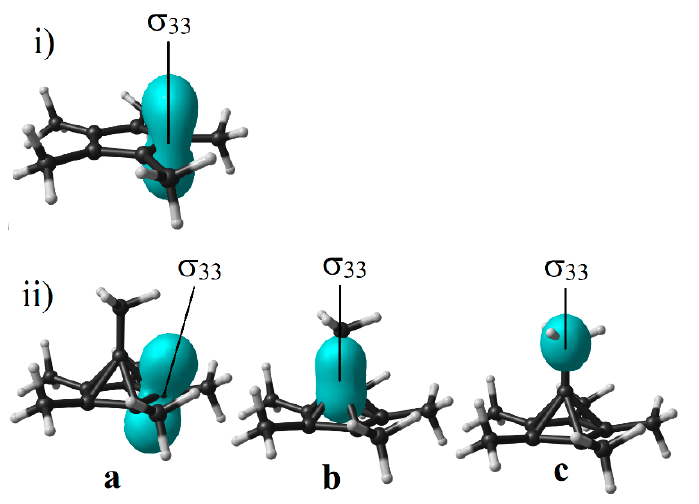
Figure 3. Isosurface representation of nuclear shielding tensor for carbon atoms located at the C 5 ring in the C 5 (CH 3 ) 5 − fragment ( i ) and C 6 (CH 3 ) 62+ ( ii , a ). In addition, the shapes of the shielding tensors located at the carbocation and attached methyl group atoms are presented in ( ii , b ) and ( ii , c ), respec- tively. Table 1. Calculated CSA parameters for different carbon atoms at C 5 (CH 3 ) 5 − and C 6 (CH 3 ) 62+ , account- ing for the 13 C-NMR spectra. Values in ppm.